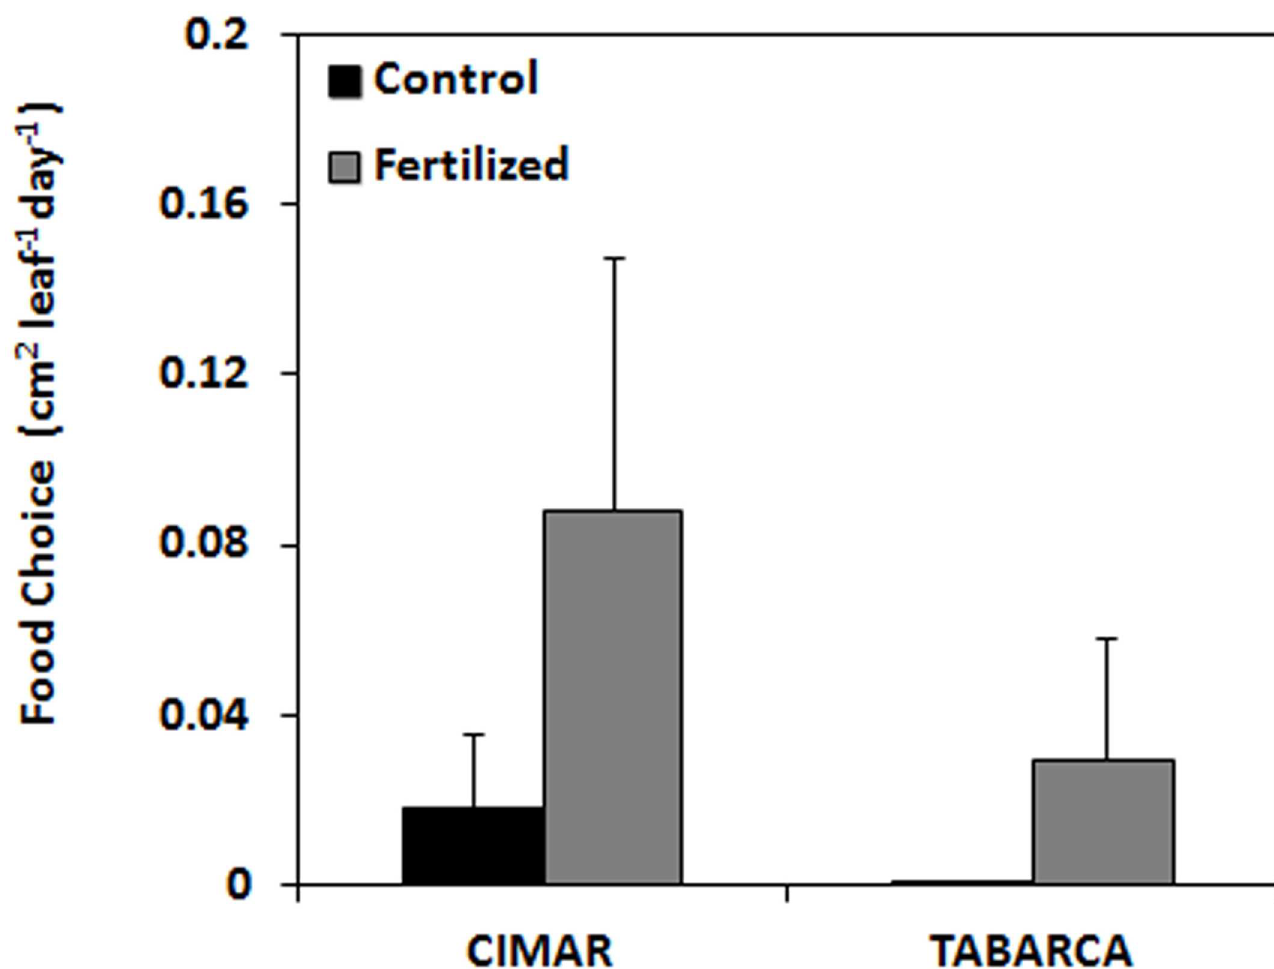
Fig 4. Consumption by S . salpa of control vs. fertilized leavesof P . oceanica during paired food preference experiments (cm 2 (cid:1) leaf -1 (cid:1) d -1 ) deployed at Tabarca and CIMAR. Mean ±